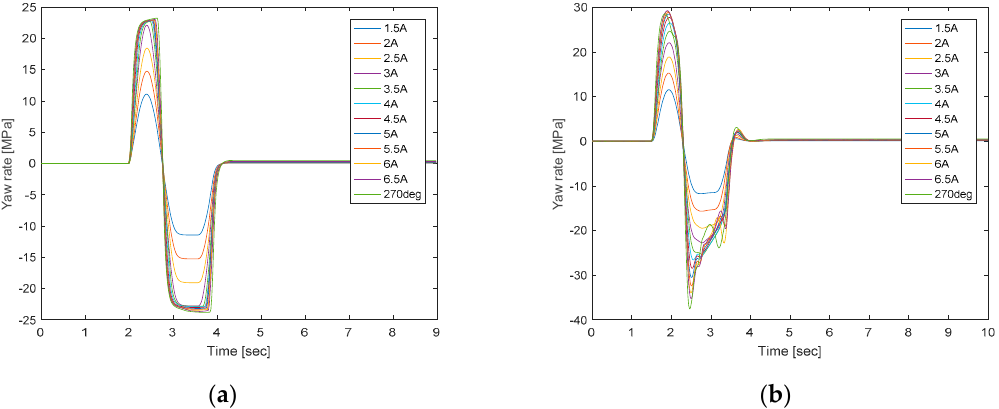
Figure 22. The yaw rate graphs of the vehicle model based on tire force observation when 𝜇 = 0.8. ( a , b ) are graphs of nominal yaw rate and actual yaw rate when the road adhesion coefficient is 0.8, using the vehicle model based on tire force observation control.